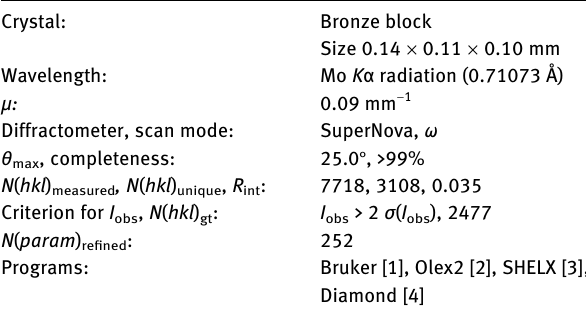
Table  : Data collection and handling.